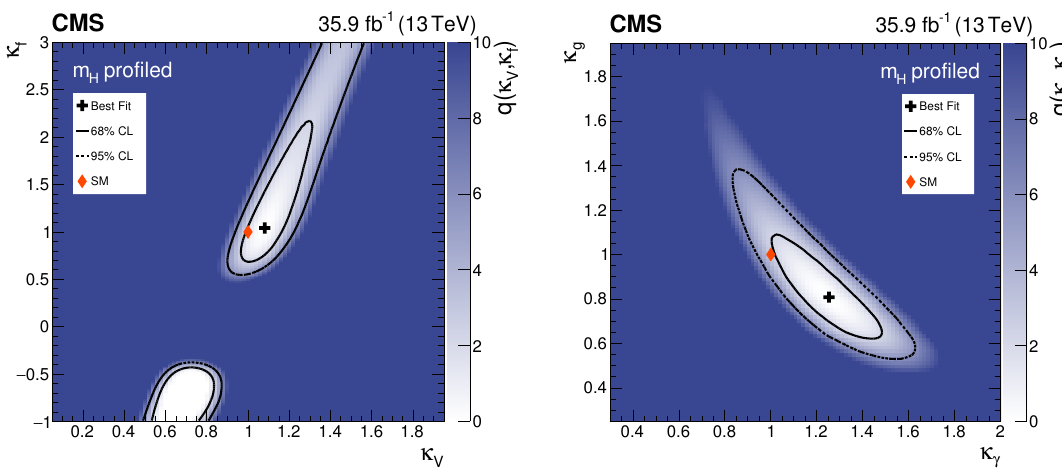
Figure 20 . Two-dimensional likelihood scans of (cid:20) f versus (cid:20) V (left) and (cid:20) g versus (cid:20) (cid:13) (right). All four variables are expressed relative to the SM expectations. The mass of the Higgs boson is pro(cid:12)led in the (cid:12)ts. The crosses indicate the best (cid:12)t values, the diamonds indicate the standard model expectations. The colour maps indicate the value of the test statistic q as described in the